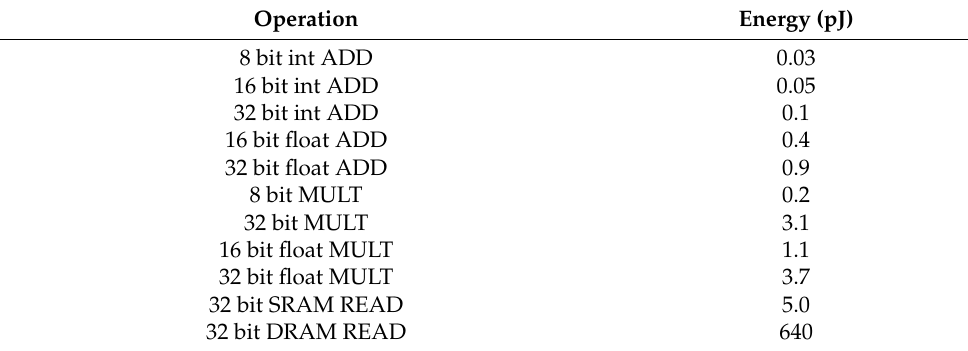
Table 17. Energy Consumption in (pJ) of performing operations.